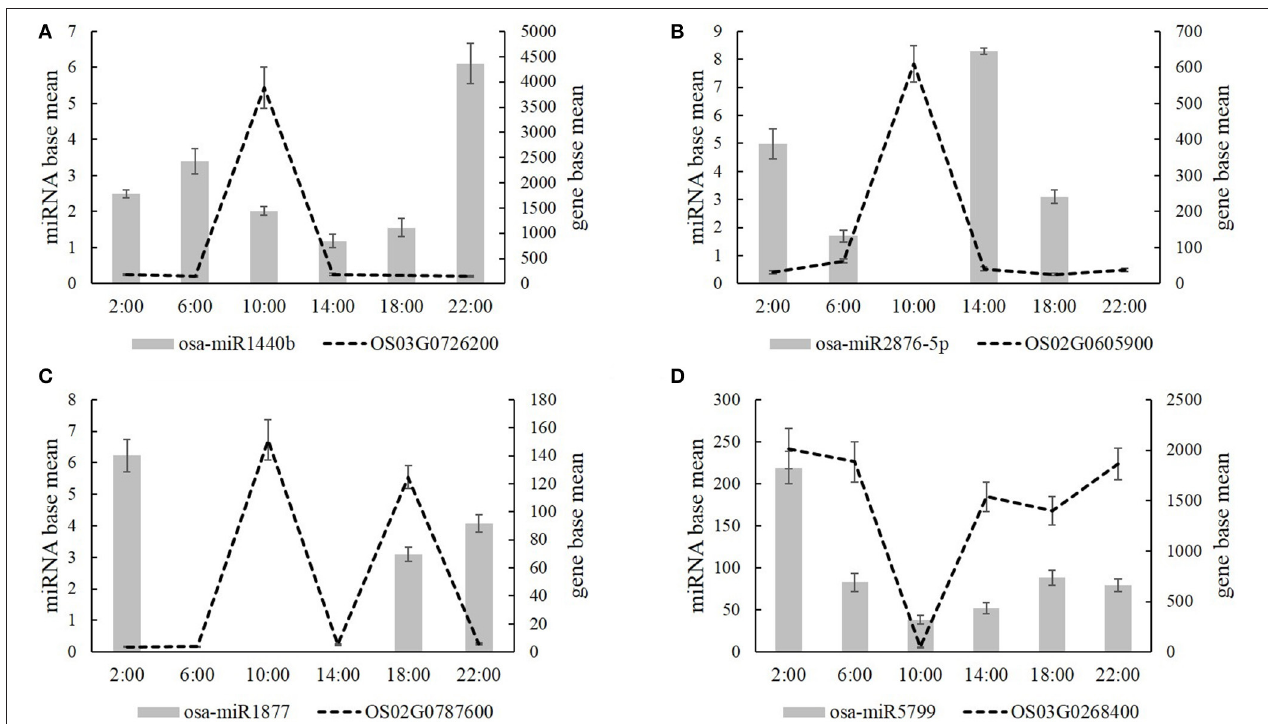
FIGURE 6 | The expression level of four carbon and nitrogen metabolism related miRNAs (A, Osa-miR1440b; B, osa-miR2876-5p; C, osa-miR1877; D, osa-miR5799) and their target genes at the time of 2:00, 6:00, 10:00, 14:00, 18:00, and 22:00. Values are mean ± SD from three biological